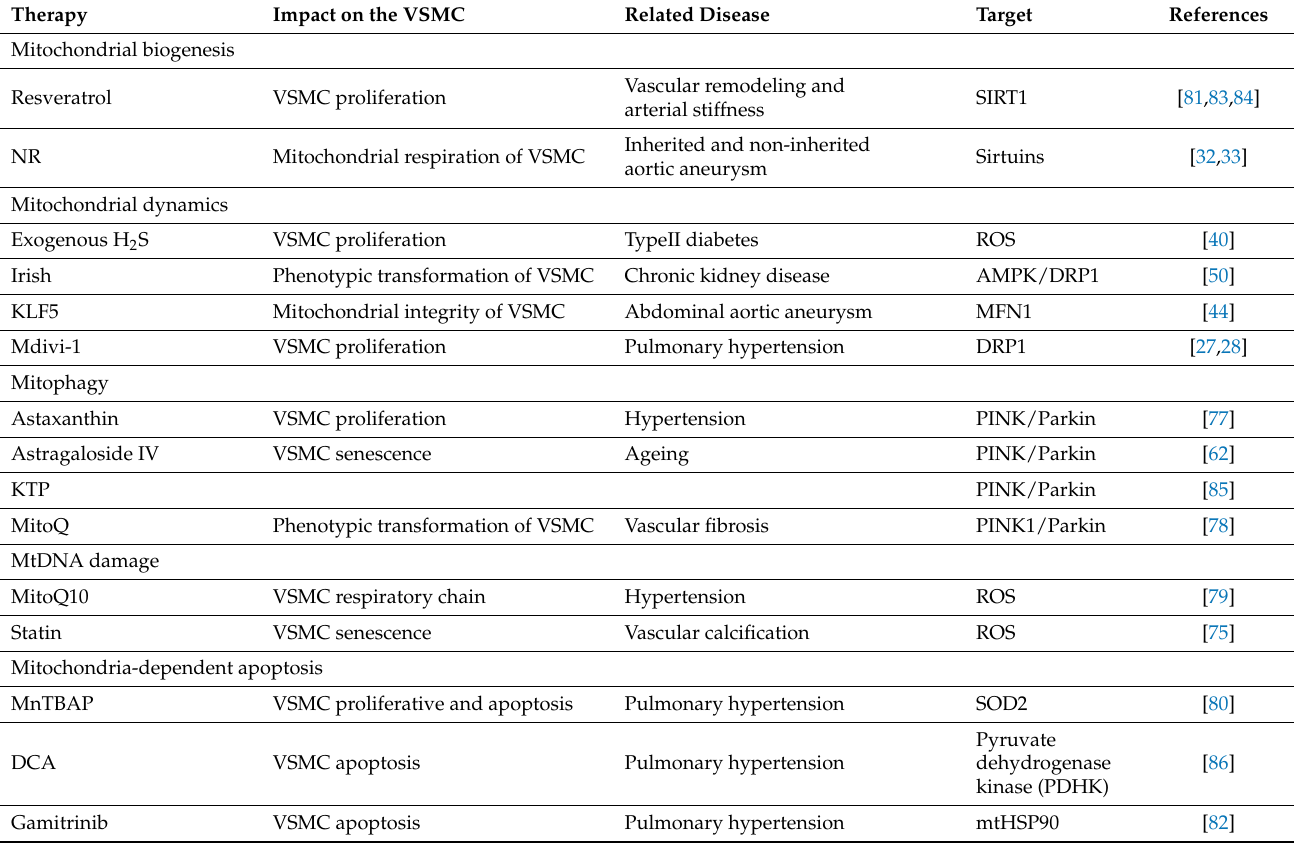
Table 1. Therapeutic drugs target mitochondria for vascular remodeling